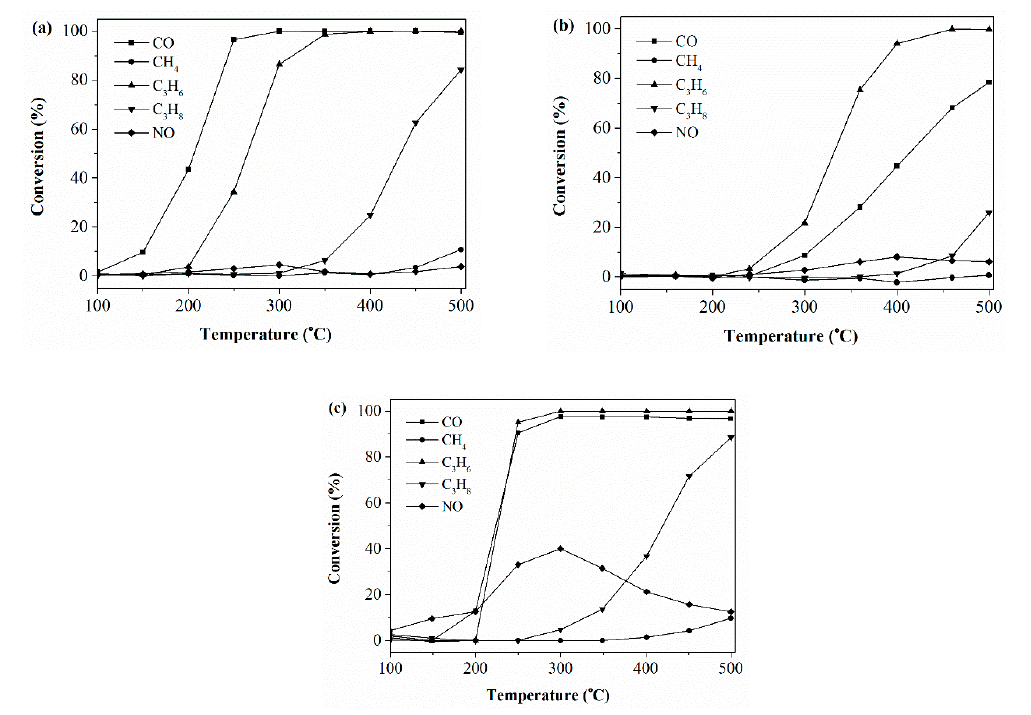
Figure 8. Catalytic performance under stoichiometric condition for Cu/SBA-15 catalyst prepared by ( a ) ADP, ( b ) MDD method and ( c ) commercial precious metal-loaded three-way catalyst. Table 2. Light-off temperature ( T 50 ) and maximum conversion ( C max ) of each component for ADP, MDD and three-way catalyst (TWC)